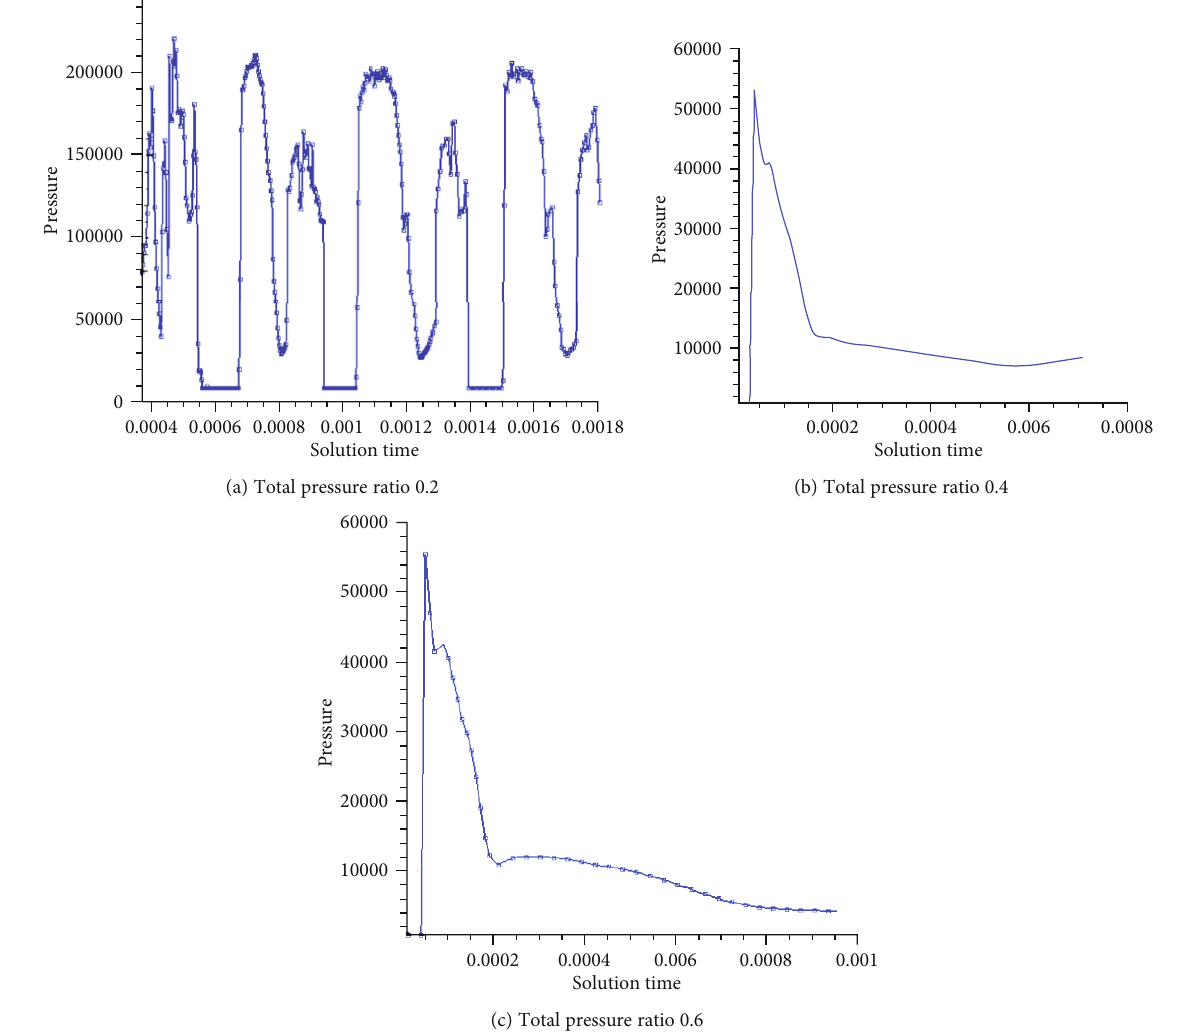
Figure 7: Pressure changes with time at a position behind the stagnation disk.